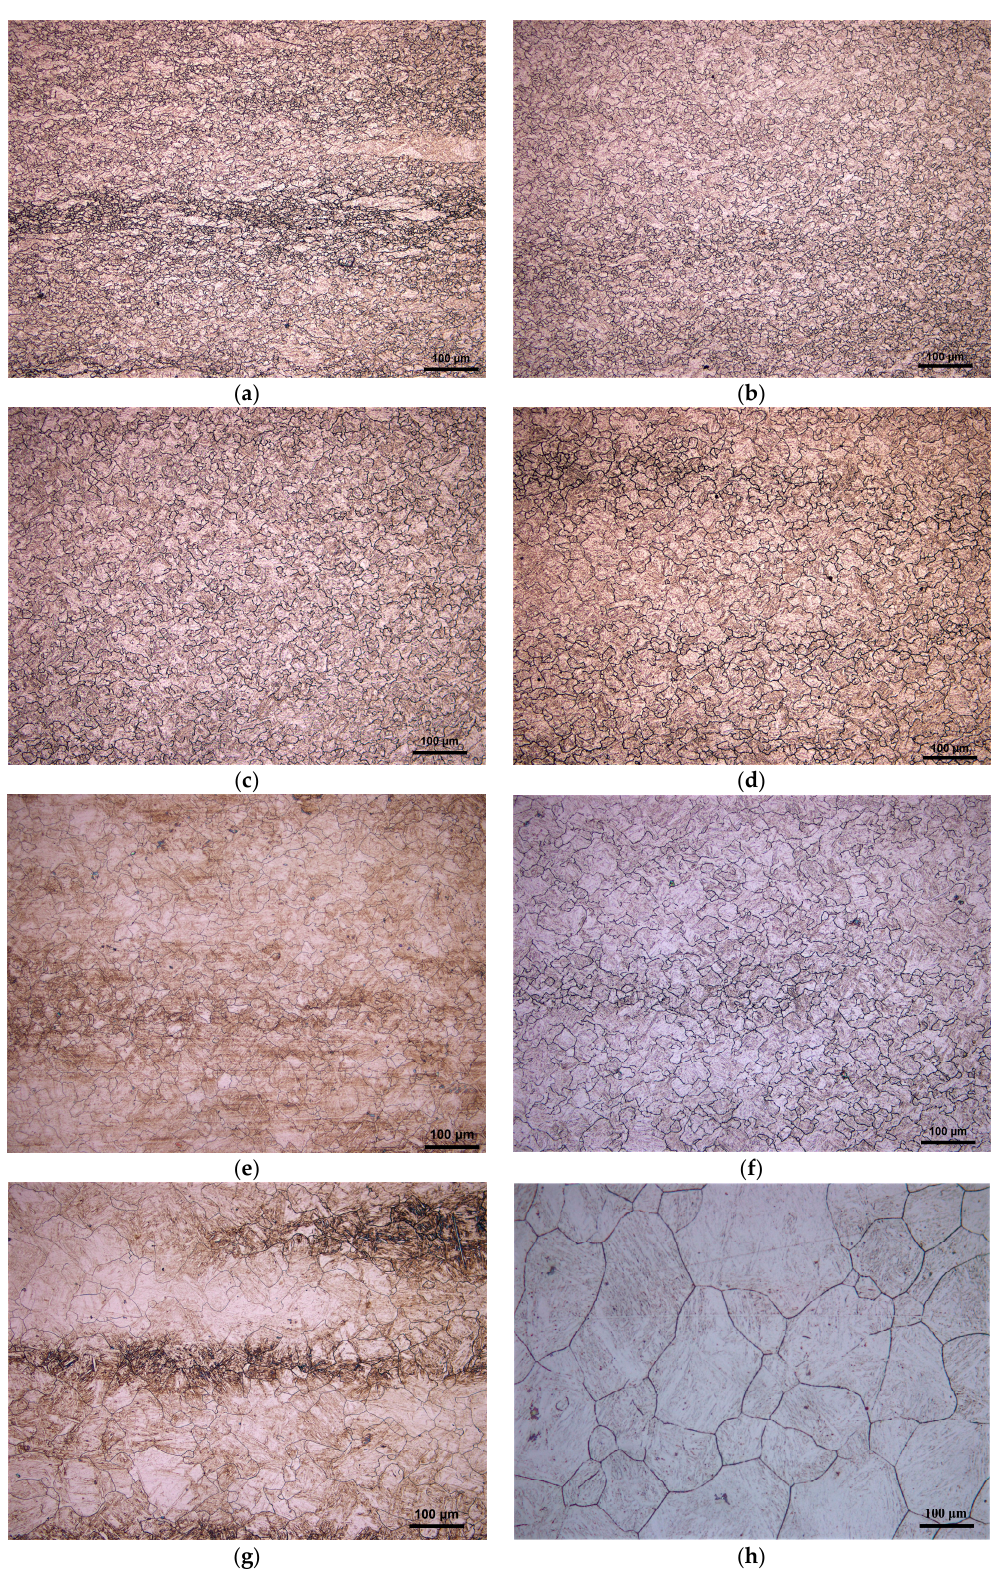
Figure 3. Microstructure of 20Mn5 steel compressed to a true strain of 0.7 under strain rate of 0.01/s and temperatures of: ( a ) 850 °C; ( b ) 900 °C; ( c ) 950 °C; ( d ) 1000 °C; ( e ) 1050 °C; ( f ) 1100 °C; ( g ) 1150 °C; ( h ) 1200 °C.